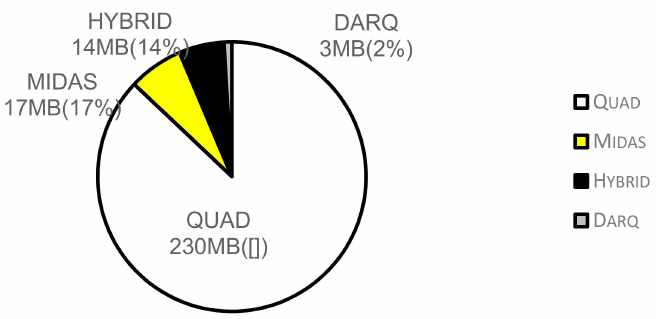
Figure 11. Storage